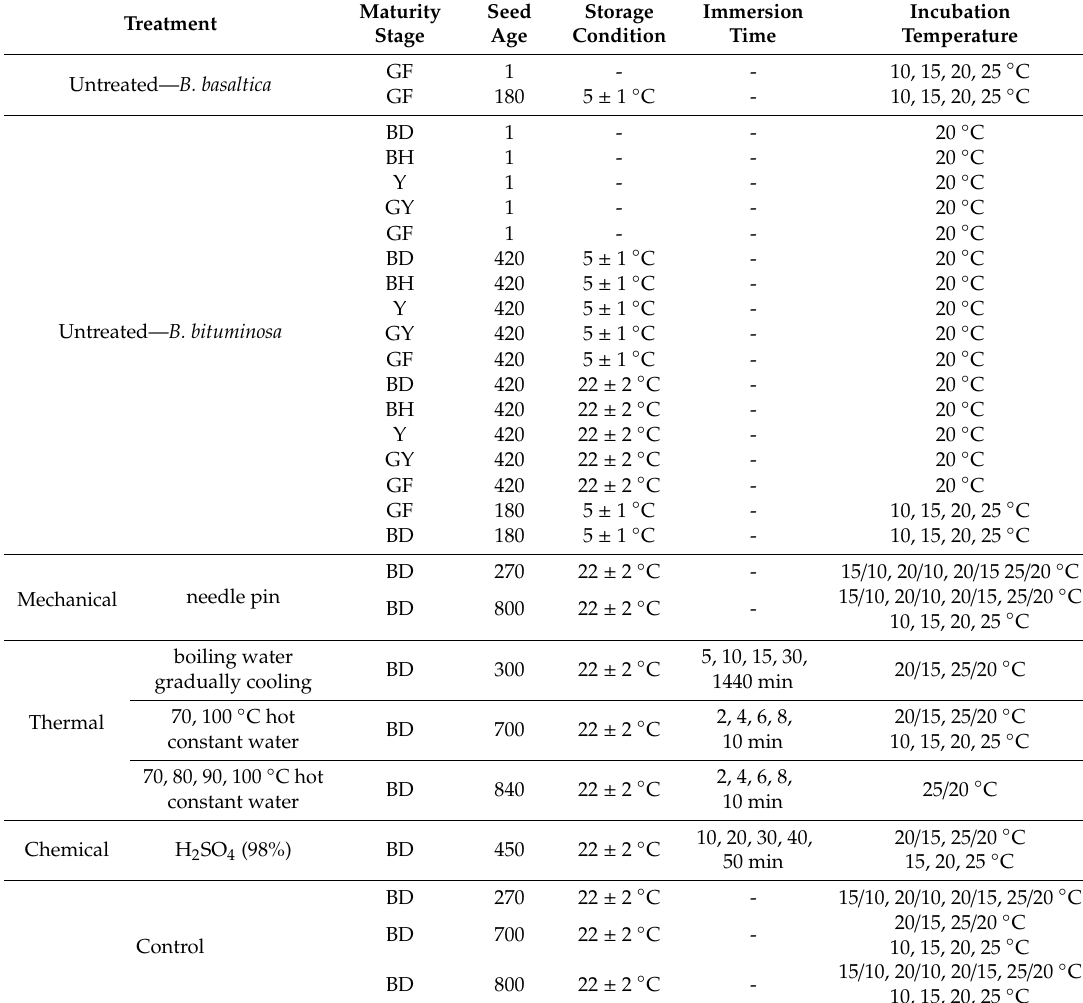
Table 2. Experimental design of the germination tests conducted in the